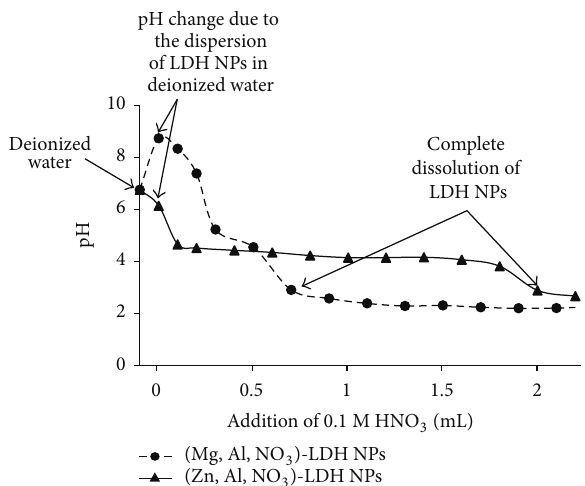
Figure 2: Titration curves to assess the pH-dependent stability of aqueous suspensions of (Mg, Al, NO 3 )-LDH and (Zn, Al, NO 3 )- LDH nanoparticles using HNO 3 (0.1M) as the